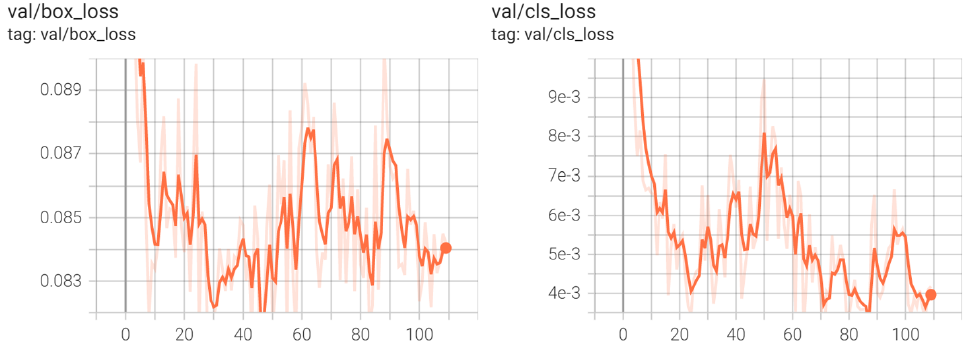
Figure 19. Validation loss representing a fluctuation in results due to insufficient datasets. Graphs of mAP (mean average precision), precision, and recall for training data of 1000 samples are displayed in Figures 20 and 21. Graphs are an excellent tool for exploratory data analysis, as they provide an overview of the relationships throughout the whole dataset.